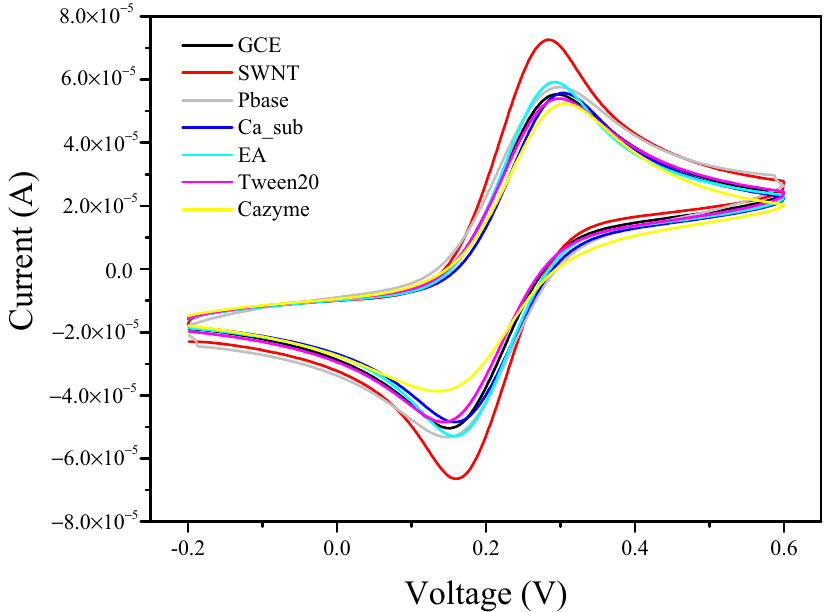
Figure 4. Cyclic voltammograms of the GCE before and after modification with SWNTs, PBASE, Ca_sub, EA, Tween 20, and CAZyme obtained in 5.0 mmol/L [Fe(CN) 6 ] 3 − /4 − and 0.1 mol/L KCl solutions at a scan rate of 50 mV/s.